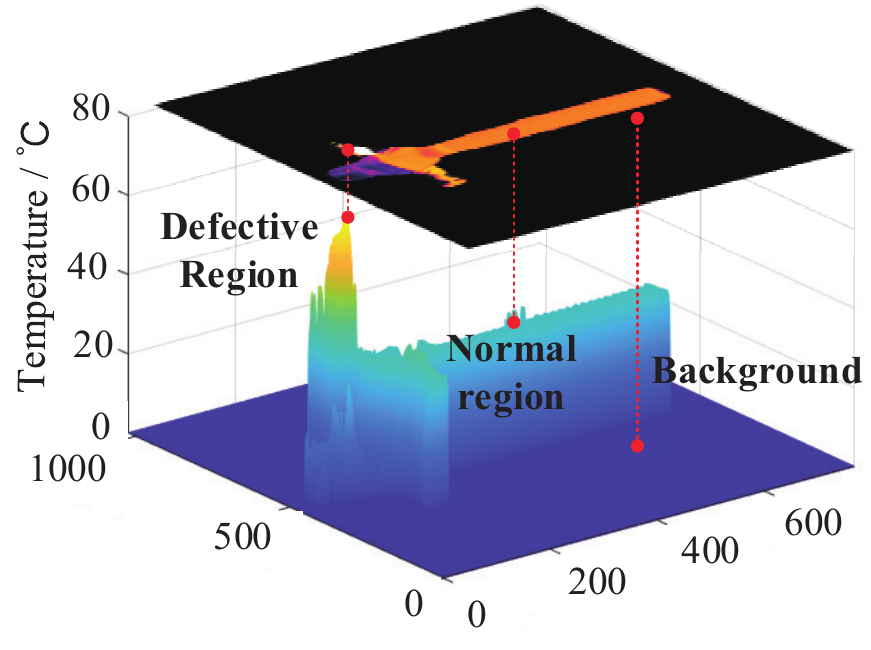
Figure 2. Infrared image of substation equipment and its temperature distribution. Different temperature characteristics correspond to different temperature probability densities. Thus, we can model the temperature probability density distribution of the instances to determine whether there are